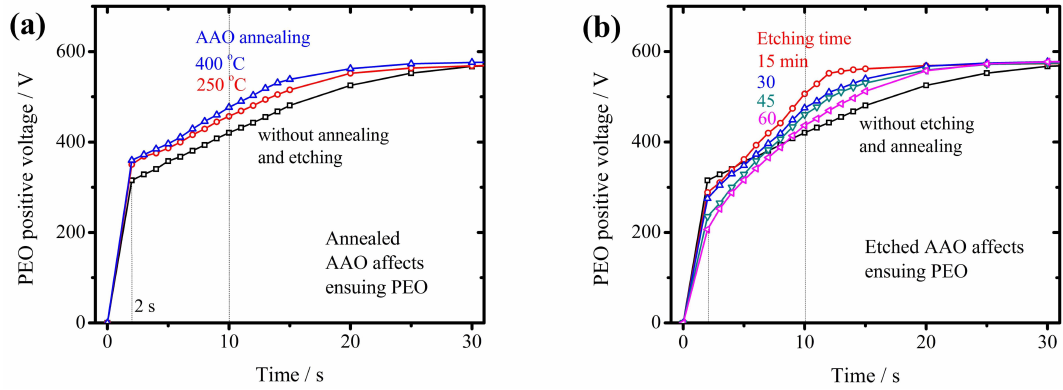
Figure9. PositivevoltageevolutionintheinitialstageofPEOtreatment. Comparisonofthevoltage-time profiles of PEO that began with ( a ) 400 and 250 ◦ C annealed barrier layer, and the barrier layer without annealing. Comparison of the voltage-time profiles of PEO that started with ( b ) the barrier layers of 15, 30, 45, and 60 min etching and the barrier layer without etching and annealing.